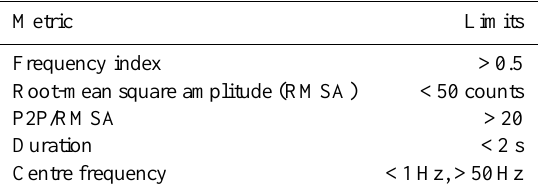
Table A2. Extreme metric values used for single-station detection noise removal. P2P refers to peak-to-peak amplitude.